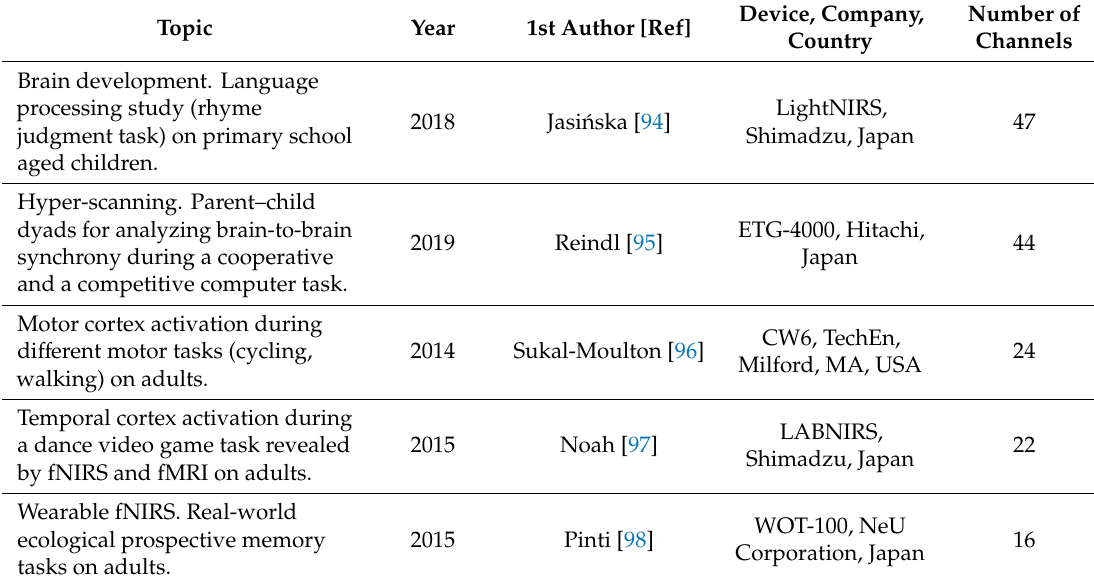
Table 3. Recent fNIRS video